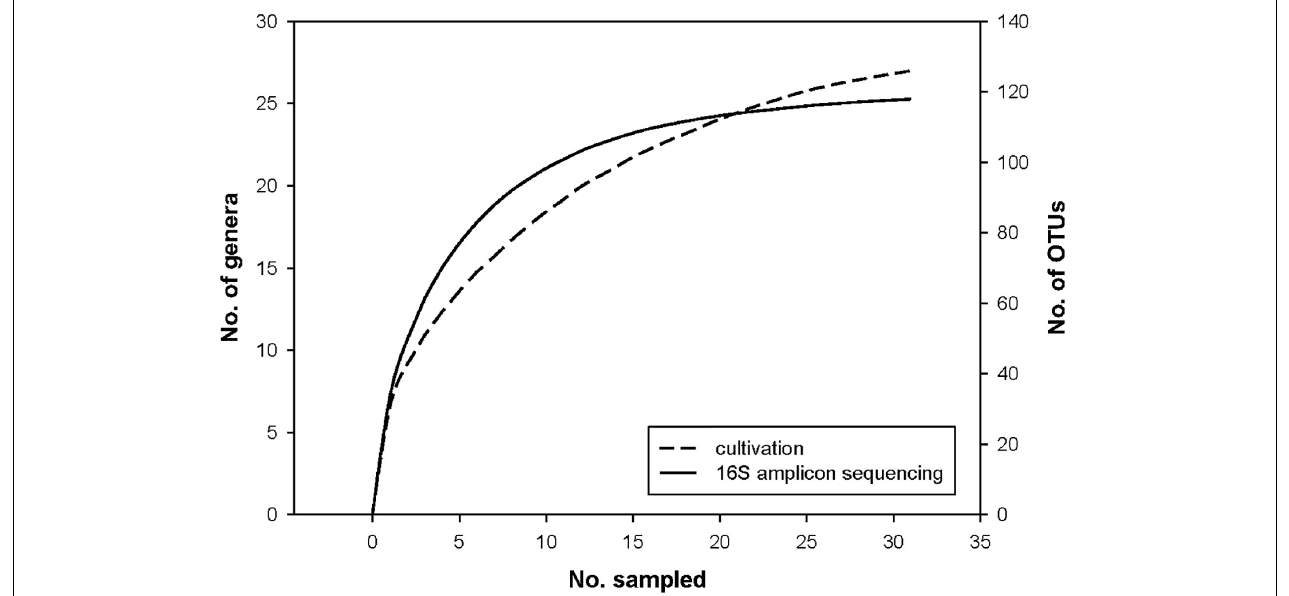
FIGURE 1 | Rarefaction curves of the 16S metagenomics sequencing and the cultivation